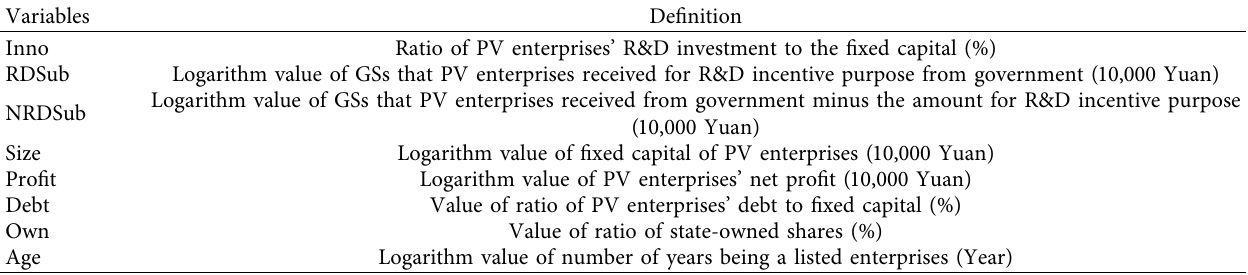
Table 1: Definition of main variables.